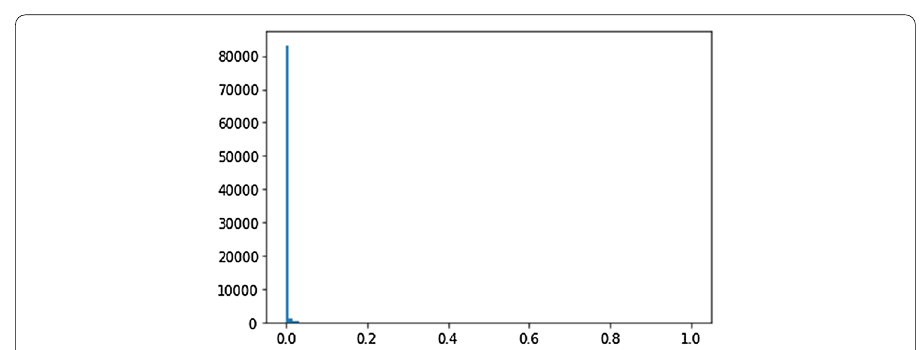
Fig. 5 ICA—Number of instances vs reconstruction error value for clean data